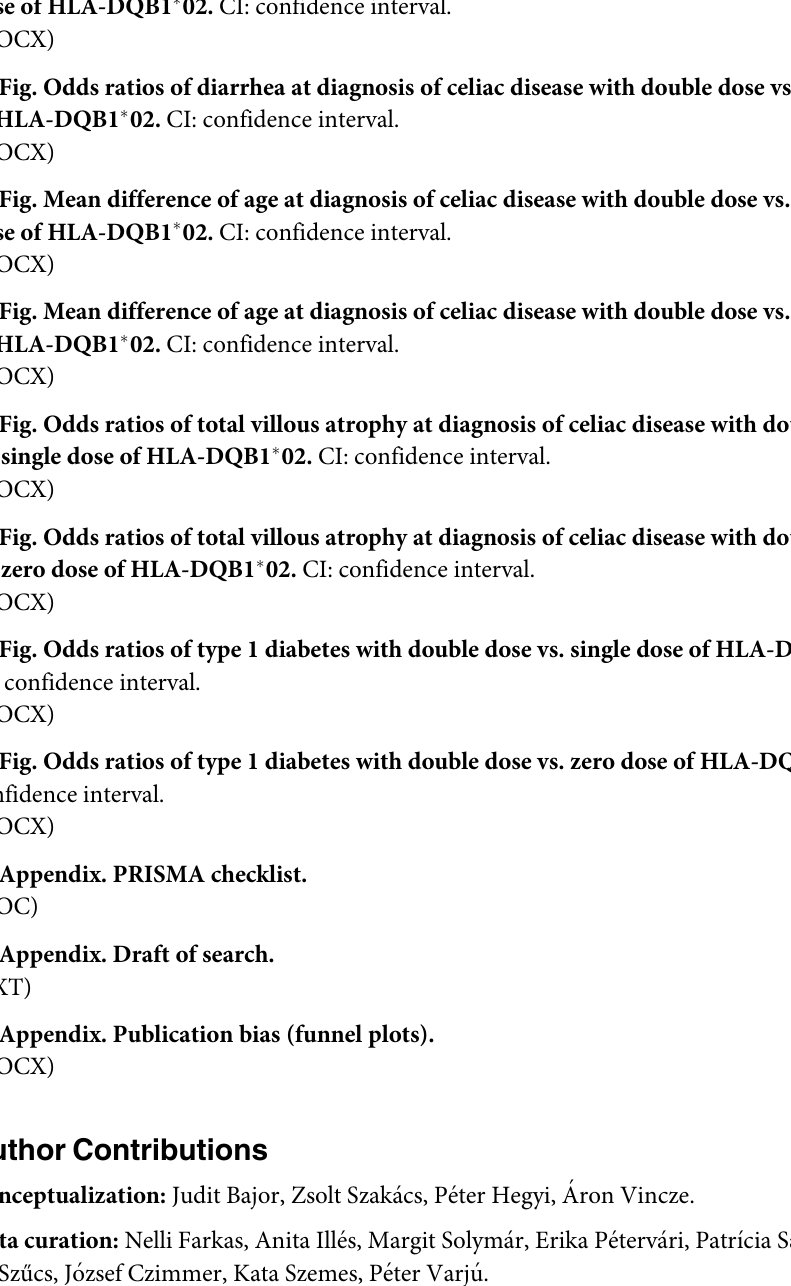
S2 Table. Papers eligible for quantitative synthesis but not included in meta-analysis. S3 Table. Data included in meta-analysis. S1 Fig. Odds ratios of diarrhea at diagnosis of celiac disease with double dose vs. single dose of HLA-DQB1 � 02. CI: confidence interval. S2 Fig. Odds ratios of diarrhea at diagnosis of celiac disease with double dose vs. zero dose of HLA-DQB1 � 02. CI: confidence interval. S3 Fig. Mean difference of age at diagnosis of celiac disease with double dose vs. single dose of HLA-DQB1 � 02. CI: confidence interval. S4 Fig. Mean difference of age at diagnosis of celiac disease with double dose vs. zero dose of HLA-DQB1 � 02. CI: confidence interval. S5 Fig. Odds ratios of total villous atrophy at diagnosis of celiac disease with double dose vs. single dose of HLA-DQB1 � 02. CI: confidence interval. (DOCX) S6 Fig. Odds ratios of total villous atrophy at diagnosis of celiac disease with double dose vs. zero dose of HLA-DQB1 � 02. CI: confidence interval. S7 Fig. Odds ratios of type 1 diabetes with double dose vs. single dose of HLA-DQB1 � 02. CI: confidence interval. S8 Fig. Odds ratios of type 1 diabetes with double dose vs. zero dose of HLA-DQB1 � 02. CI: confidence